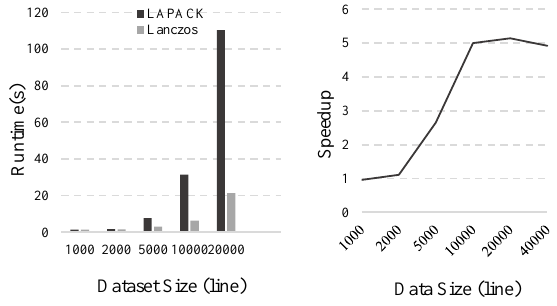
Figure12. Runtime and speedup comparison for Lanczos and LAPACK.